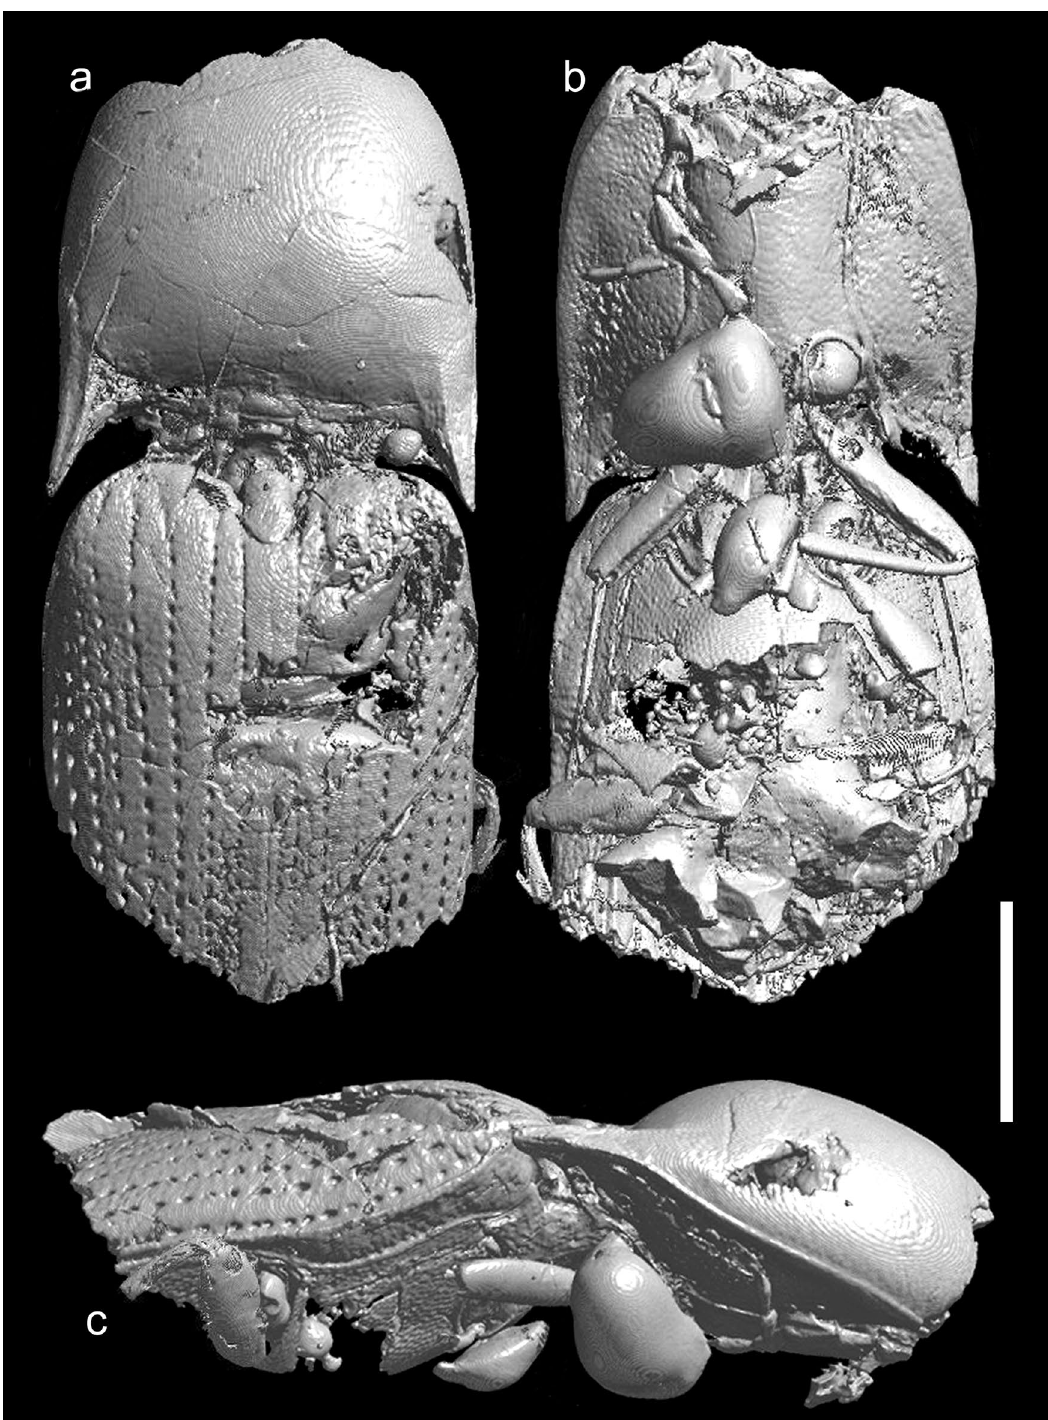
Figure 2. Ajkaelater merkli gen. et sp. nov., holotype (MTM PAL 2021.50.1.). ( a ) Dorsal view; ( b ) ventral view; ( c ) right lateral view. Scale bar: 1 with antennomeres VI–IX and X–XI. Preserved antennomeres (Figs. 2b, 3a) weakly serrate, presumed antenno- meres VI–X subequal in length, about twice as long as wide, apical antennomere simple, about 1.20 times as long as penultimate antennomere. Pronotum (Figs. 2a, 3b) slightly wider than long when measured along midline (length: 1.75 mm, width: 1.90 mm), widest at posterior angles but only slightly wider there than in about middle. Anterior angles inconspicuous; lateral sides from dorsal view weakly rounded; posterior angles moderately long, sharp, slightly divergent, each medially with distinct sublateral carina running from apex of angle and slightly surpassing posterior margin of pronotum, not subparallel with lateral carina but both carinae divergent anterad